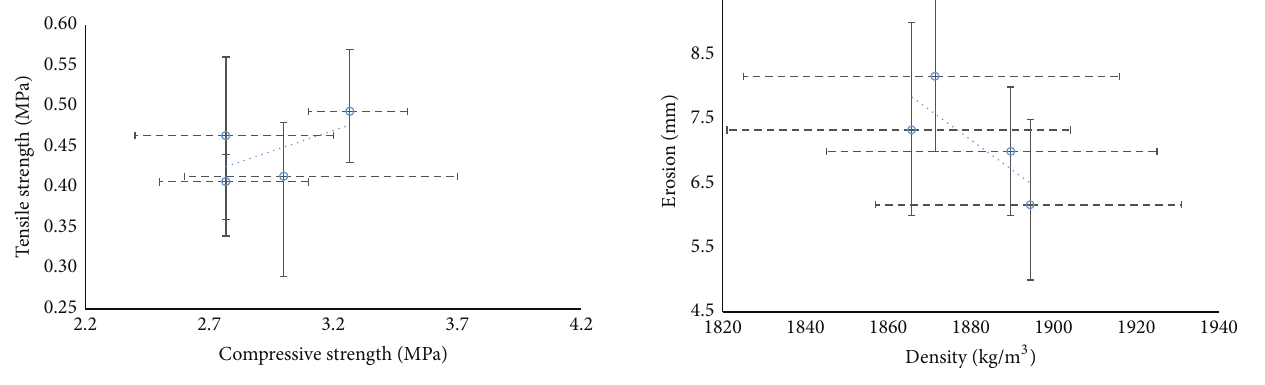
Figure 11: Correlation between tensile and compressive strengths.